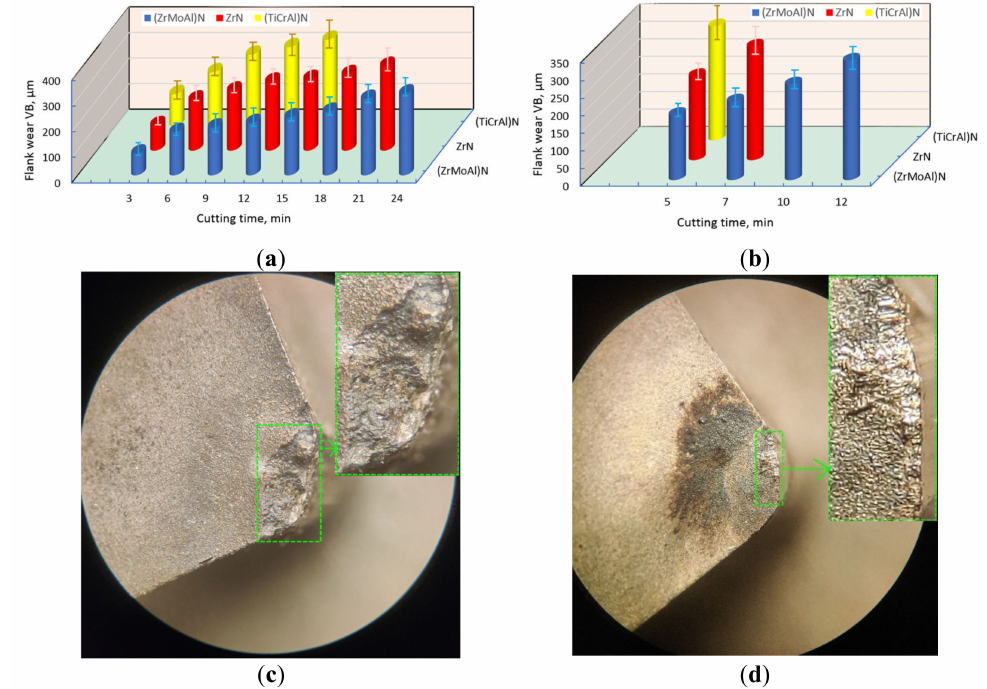
Figure 4. Relationship between the flank wear VB and the cutting time during the turning of Inconel 718 at various cutting speeds: ( a ) v c = 125 m/min and ( b ) v c = 200 m/min. View of the worn rake face of a tool coated with ( c ) (Ti,Cr,Al)N and ( d ) (Zr,Mo,Al)N, v c = 200 m/min. At the cutting speed of v c = 200 m/min, the tool life of the uncoated tool was less than 5 min. At the same cutting speed, the longest tool life was also exhibited by the tool with the coating of (Zr,Mo,Al)N (12 min). Meanwhile, the tool lives of the tools with